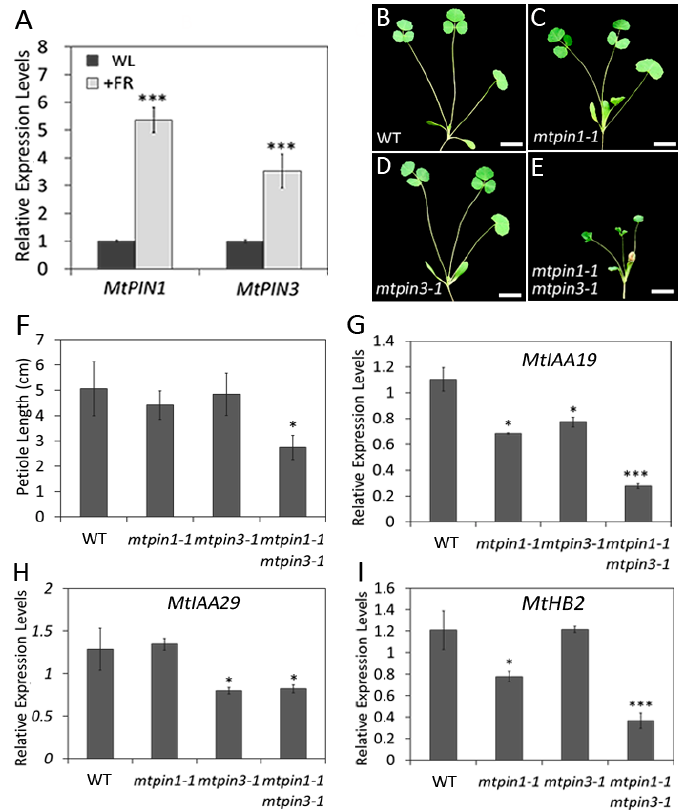
Figure 7. The plants of mtpin1 mtpin3 fail to respond to low R:FR ratio light. ( A ) Relative expression levels of MtPIN1 and MtPIN3 at petiole in wild-type under white light (WL) and a low R:FR ratio light (R:FR ratio = 0.1). ( B – E ) Phenotype of 45-day-old wild-type (WT) ( B ), mtpin1-1 ( C ), mtpin3-1 ( D ), and mtpin1-1 mtpin3-1 ( E ) under a low R:FR ratio light. ( F ) The petiole length of wild-type and mutants under low R:FR light. ( G – I ) Relative expression levels of MtIAA19 ( G ), MtIAA29 ( H ), and MtHB2 ( I ) under low R:FR light. Values are the means and SD of three biological replicates. * p < 0.05, *** p < 0.001. Bars = 1 cm in ( B – E